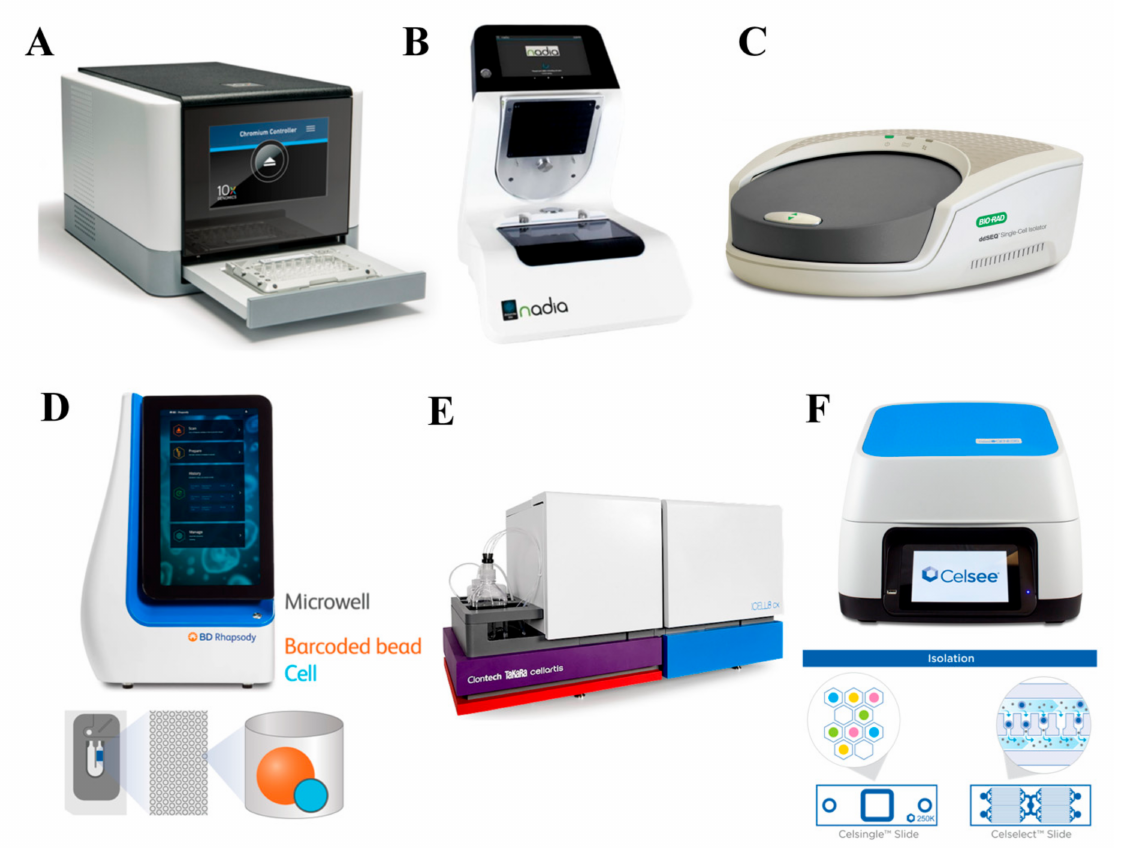
Figure 8. Commercial scRNA-seq technologies. There are several scRNA-seq technologies available in the market such as the ( A ) chromium system (10x genomics) (adapted with permission